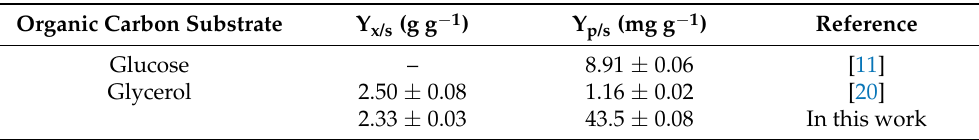
Table 4. Comparison of yield parameters of D . salina grown in glucose and glycerol from the literature and in the best experimental conditions in this